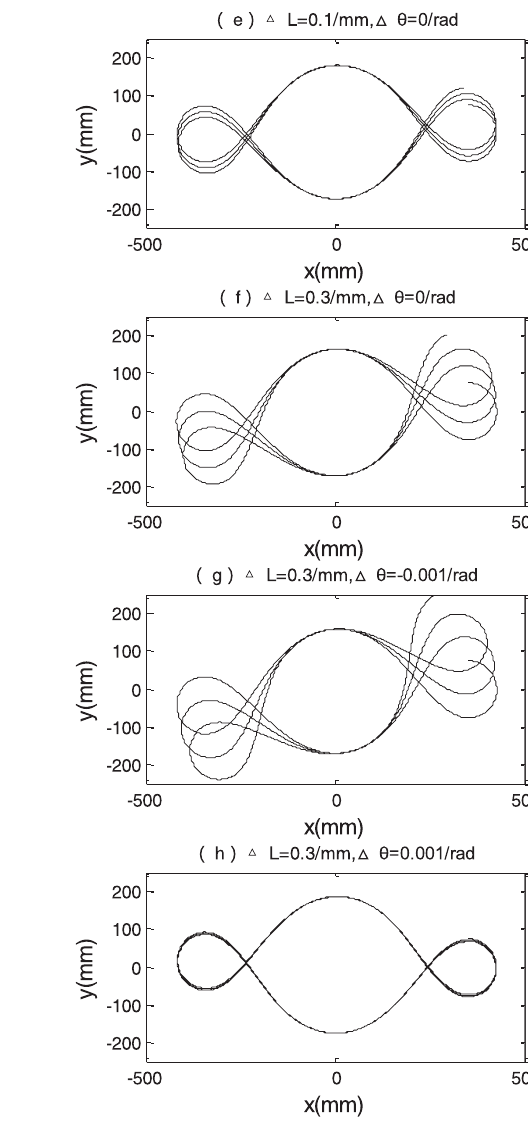
Fig. 5. Trajectory at different